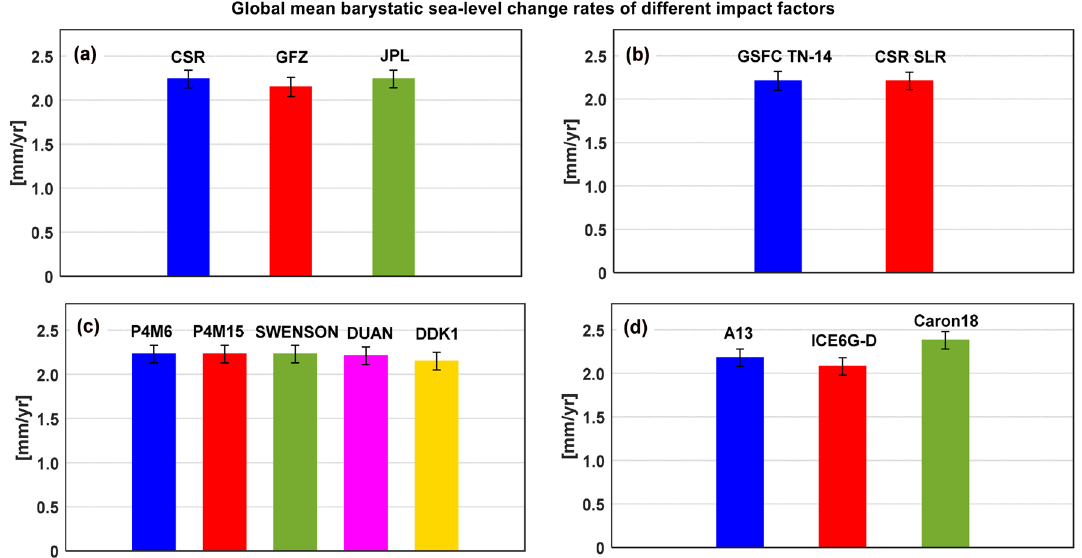
Figure 4. The linear trends of four potential impact factors on global mean barystatic sea-level change estimations over the study period. ( a ) Processing center, ( b ) C 20 correction, ( c ) Filtering method and ( d ) GIA correction.